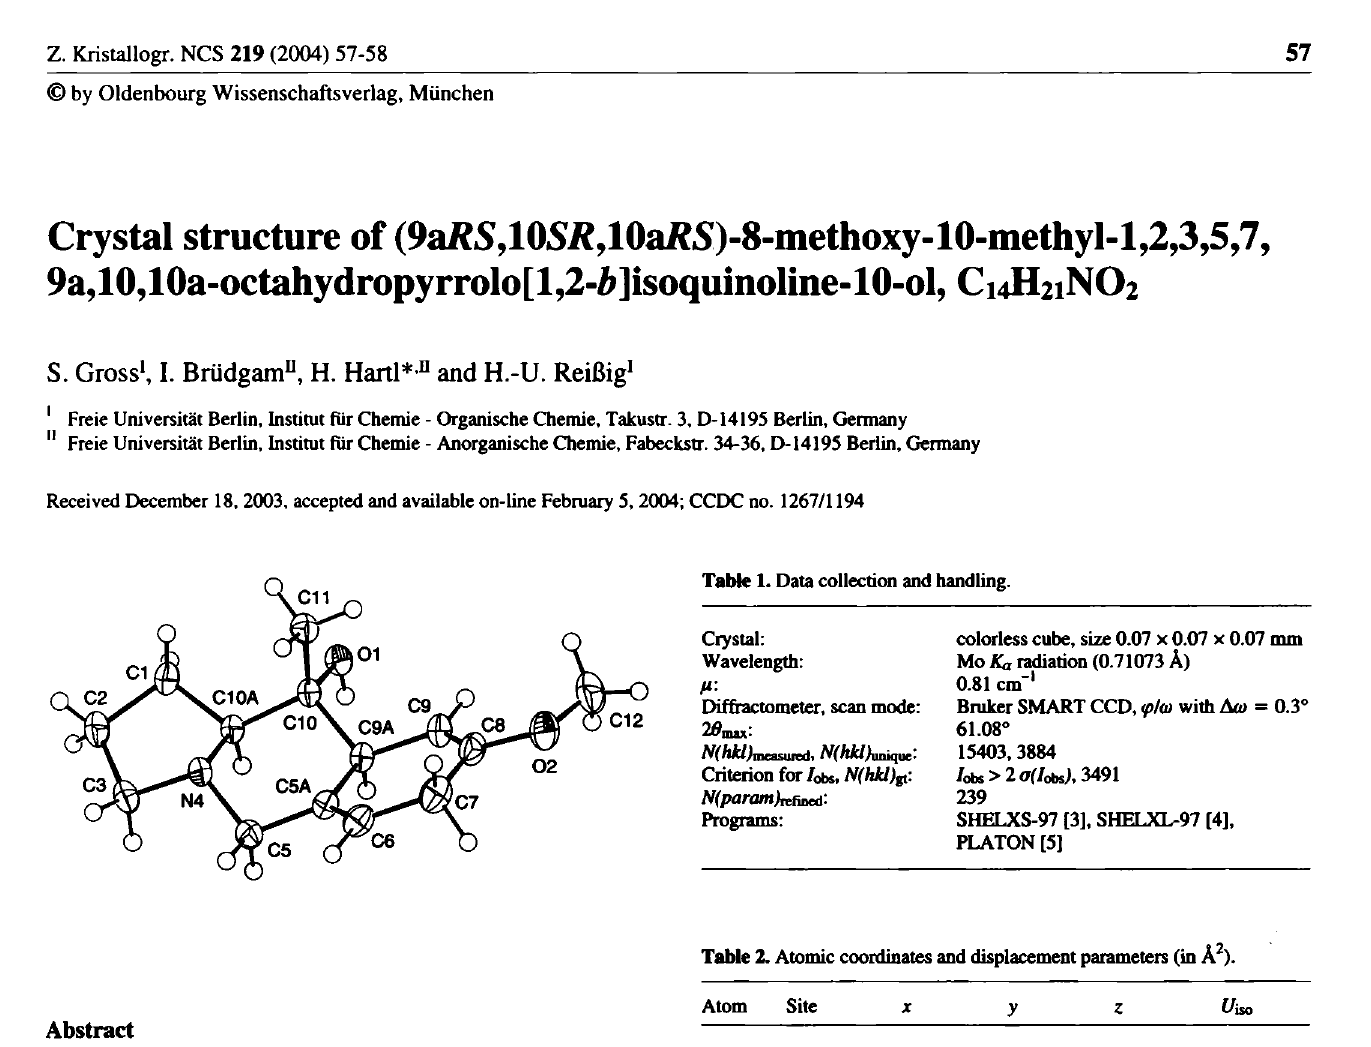
Table 2. Atomic coordinates and displacement parameters (in A 2